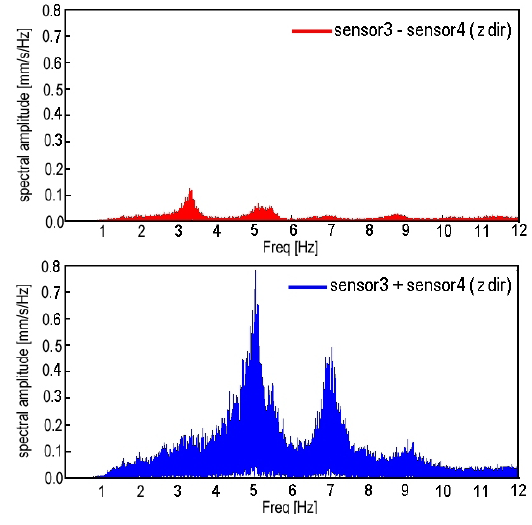
Figure 8. Spectral amplitudes of the sum (blue line) and the dif- ference (red line) of the signals recorded along the z direction in section C by stations 3 and 4 during Test